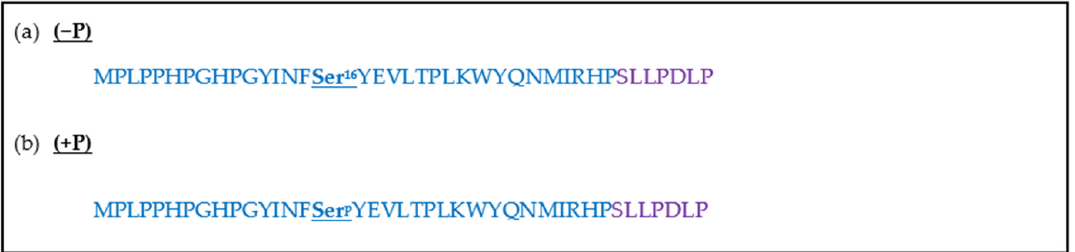
Figure 5. ( a ) Non-phosphorylated sequence at Ser 16 of porcine N-terminus (blue) in the presence of partial C-terminal motif (purple). ( b ) Phosphorylated sequence at Ser 16 of porcine N-terminus (blue) in the presence of partial C-terminal motif (purple).